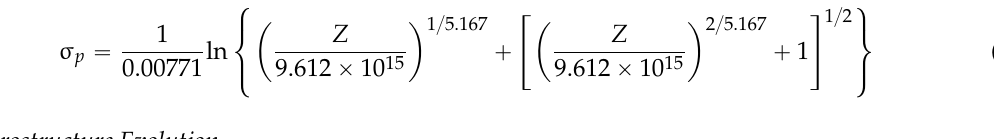
curve. However, microstructure observation is a more complicated and time-consuming method compared to the flow stress curve analysis, as it requires a large number of samples for examination. The flow stress curve analysis method, firstly proposed by Kocks and Mecking [23], and then further developed by McQueen and Ryan [24], can be used to emphasize the point where DRX occurs on the flow stress curve.